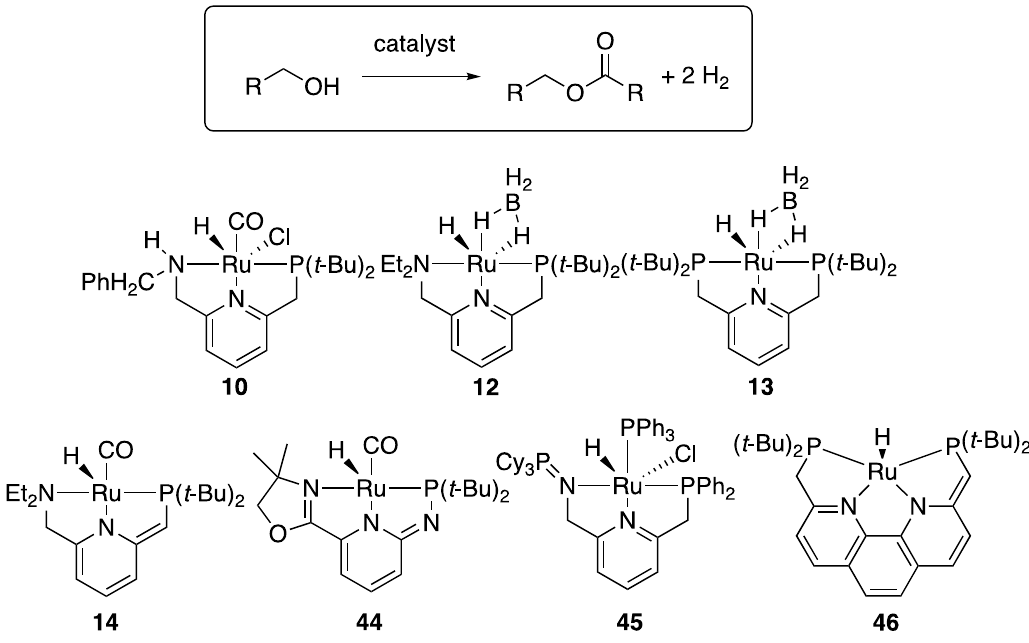
Figure 3. Ru-pincer complexes for catalytic dehydrogenative coupling of alcohols to esters.